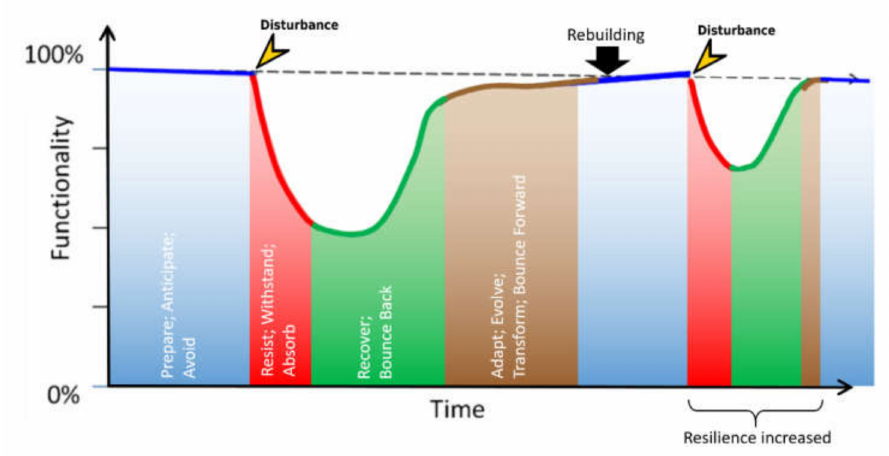
Figure 3. Schematic representation of the learning effect. A system is influenced by a disturbance and loses functionality. This loss must be resisted. Through the process of restoration and